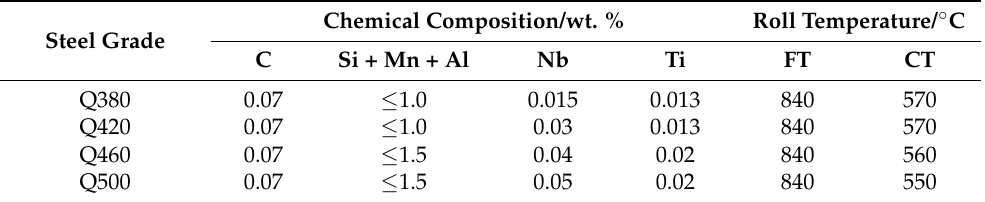
Table 1. Chemical composition and rolling temperature of the prepared